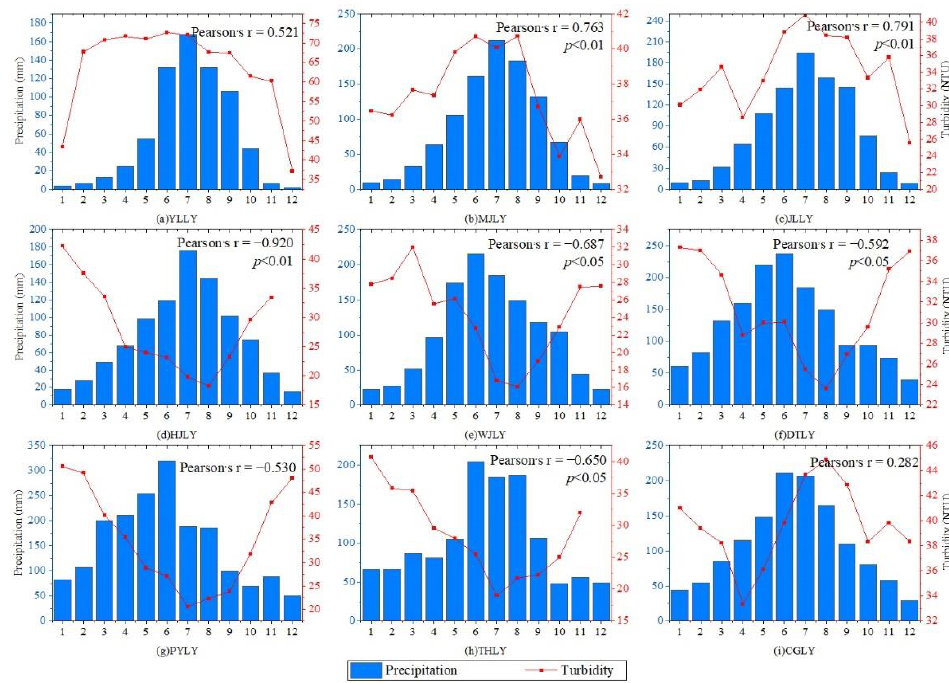
Figure 14. Variations of monthly precipitation and turbidity in the secondary watersheds from 1986 to 2021.